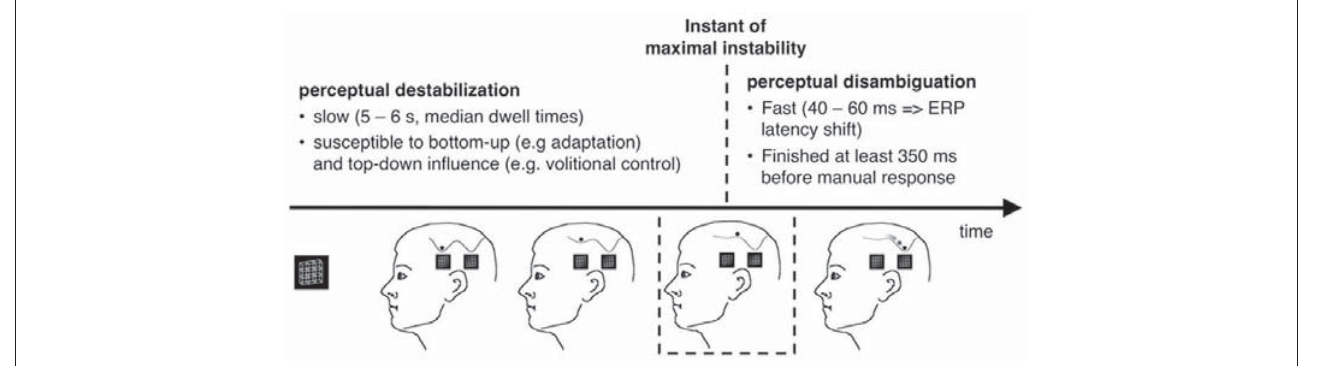
FIGURE 12 | Destabilization and disambiguation of ambiguous visual information. With prolonged observation of the ambiguous lattice stimulus a transiently stable percept gets destabilized slowly, symbolized as a depth reduction of the brain states current attractor. Both bottom-up and top-down